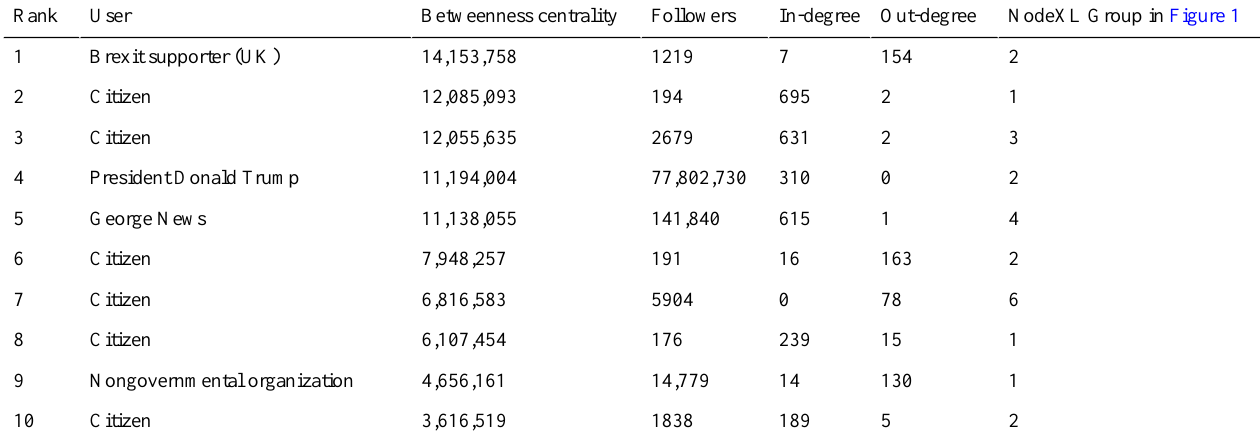
Table 4. Influential